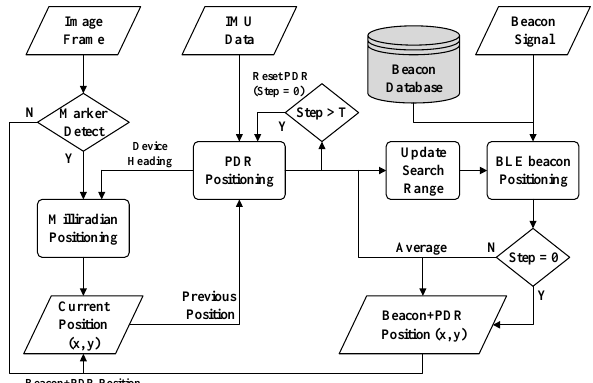
Figure 10. Flow chart of hybrid positioning algorithm (App. 3) using BLE beacon, PDR, and marker detection.